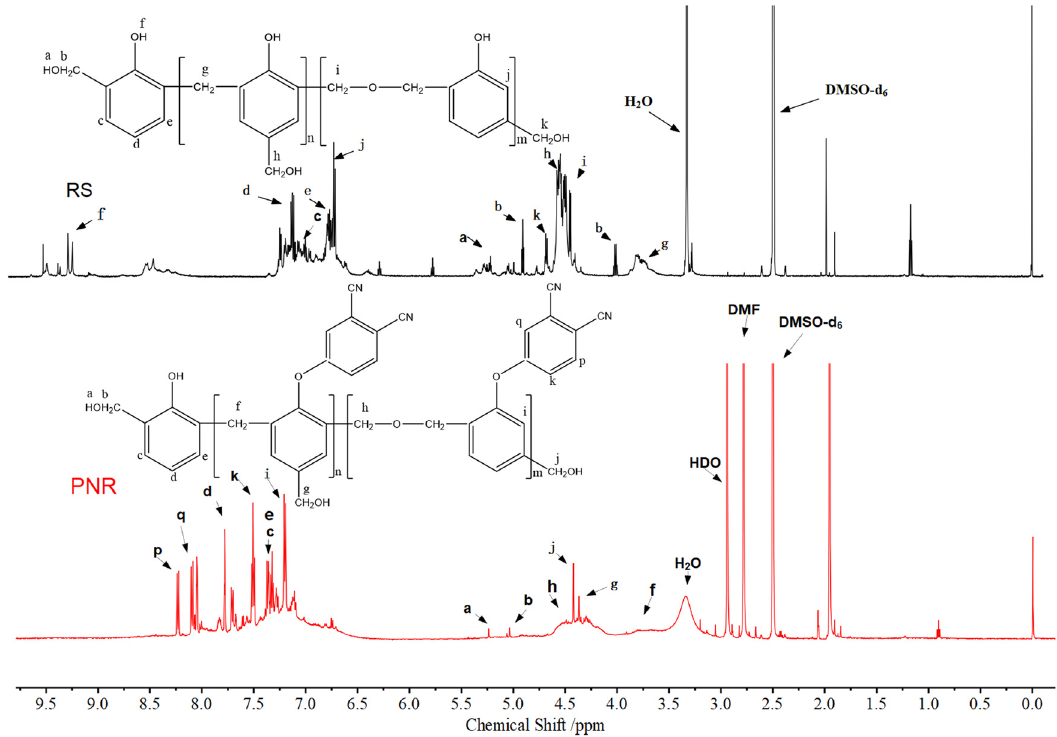
Figure 3: 1 H NMR spectra of PNR and RS.